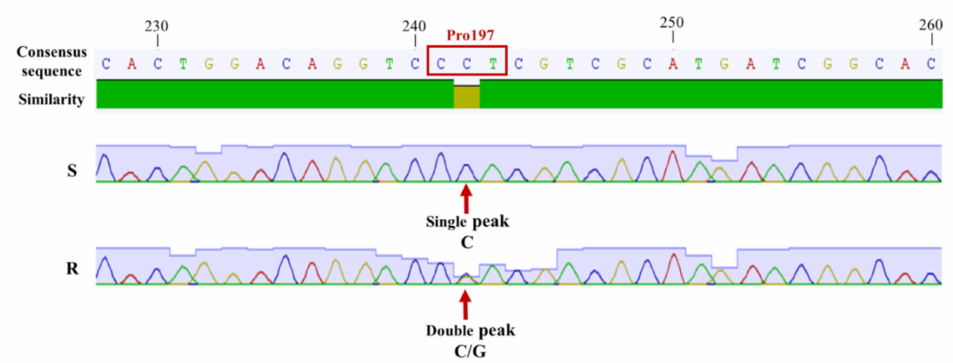
Figure 2. Schematic magnification of nucleotide sequence alignment of C. esculentus ALS sequenced fragments obtained from S and R biotype sequences around the Pro 197 codon position in the red box. The chromatogram reveals the single peak corresponding to C in S biotype (at 242 nt position), while the double peak for C and G is evident for R biotype. The % level of similarity between the aligned sequence is indicated in light